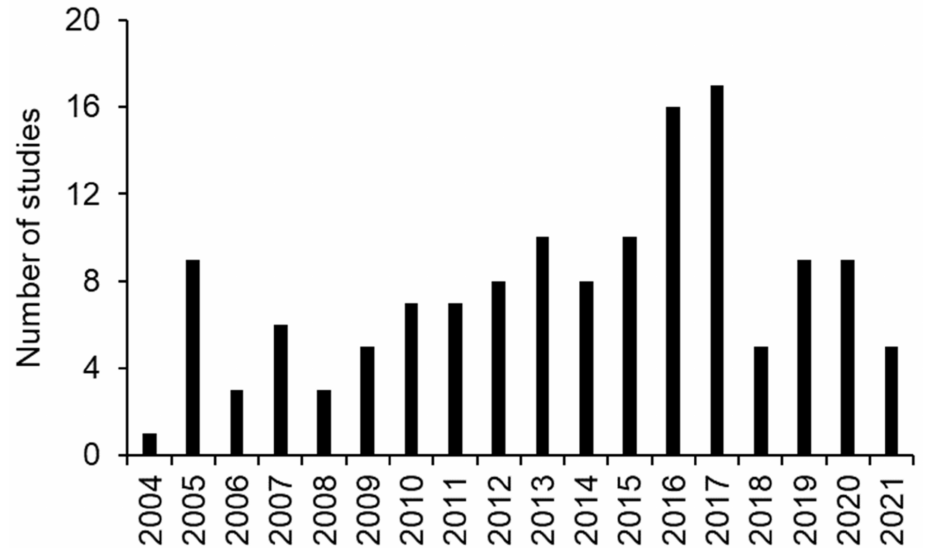
Figure 2. Number of completed clinical trials in TBI in each year from